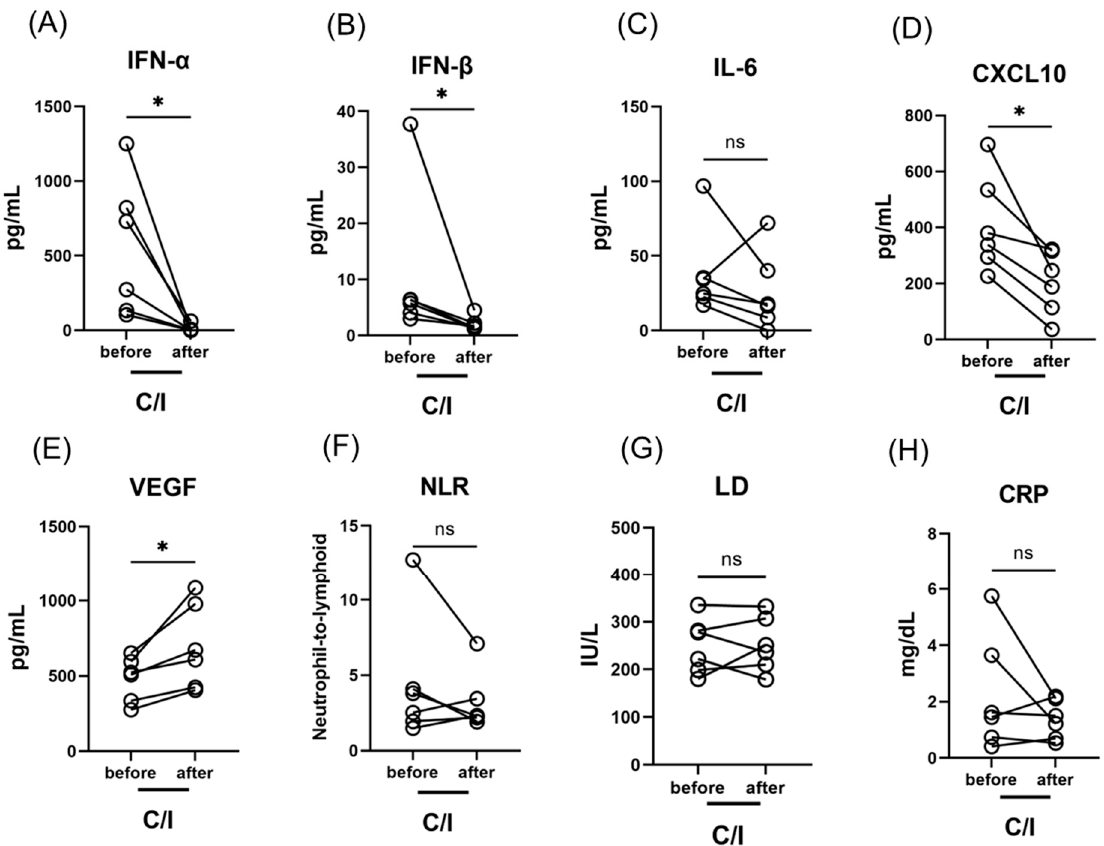
Figure 4. Serum type I IFN, pro-inflammatory cytokine levels and laboratory findings in